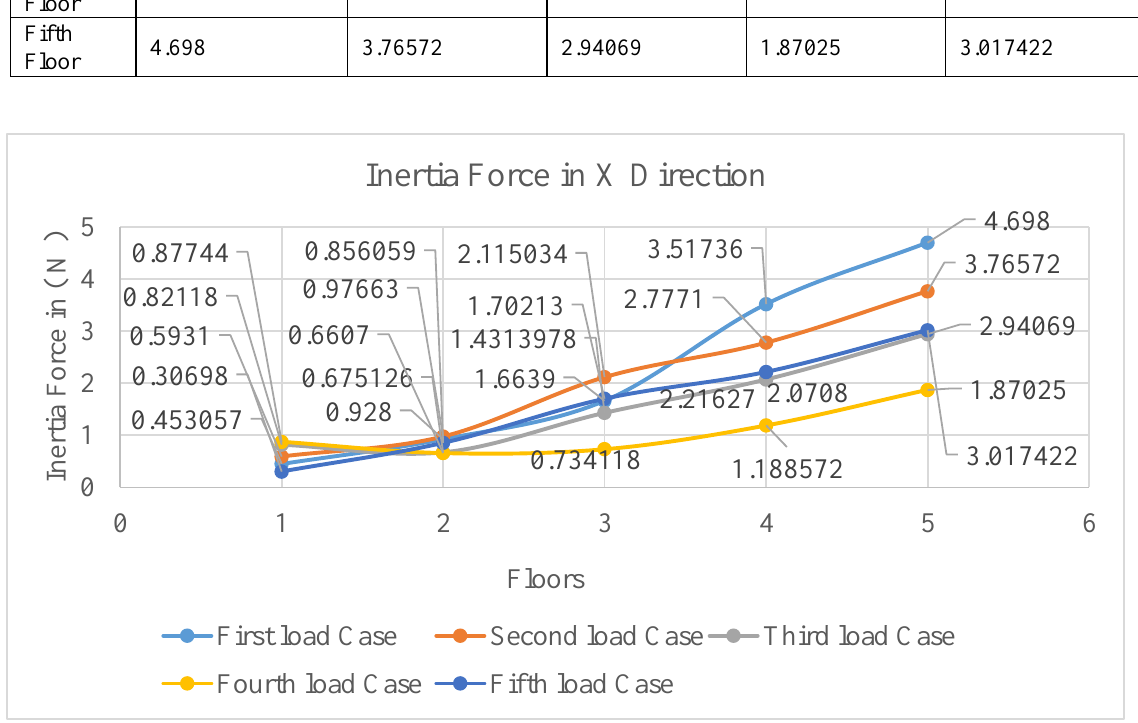
Fig. 5. Inertia Forces